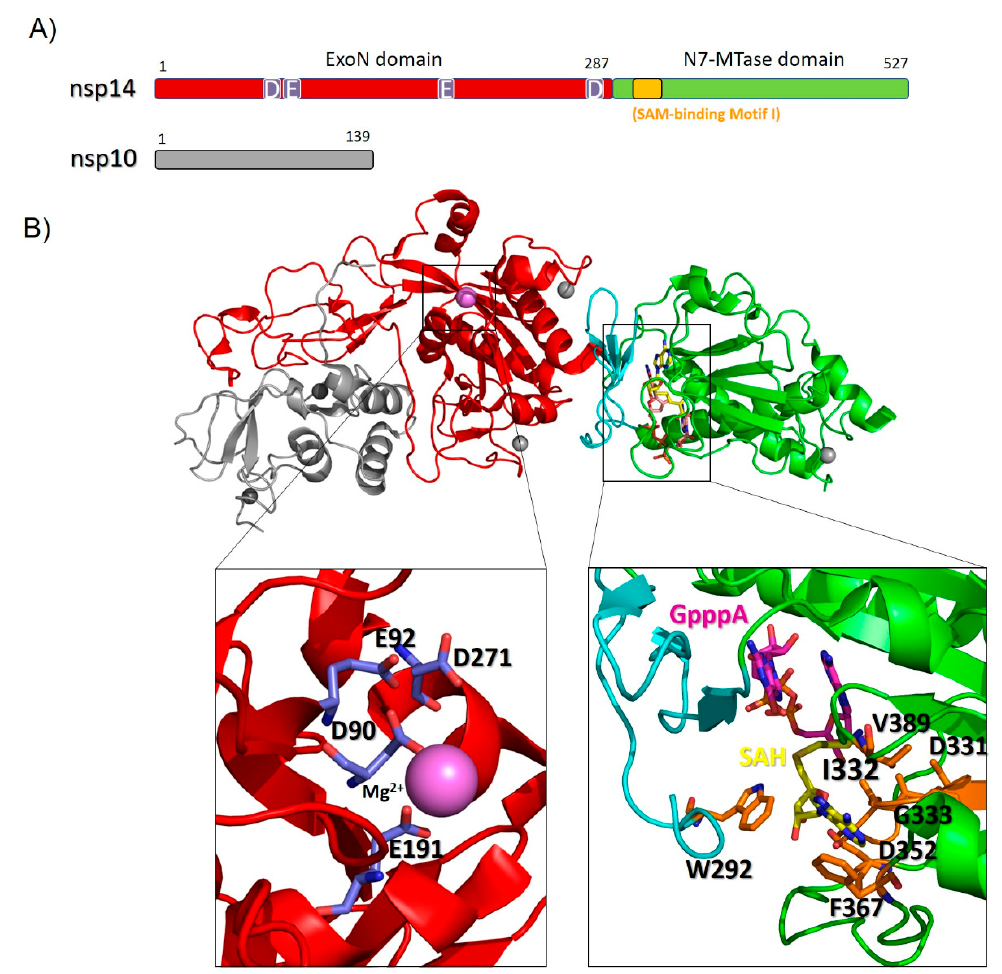
Figure 5. Homology model of SARS-CoV-2 Nsp14-Nsp10 complex. ( A ) Domain organization of Nsp14 and Nsp10; ( B ) Cartoon representation of the homology model of the complex, computed with MODELLER using the structure of its homolog from SARS-CoV as a template (PDB code 5C8S, covered region 1 − 131 in Nsp10 and 1 − 525 in Nsp14). Zinc atoms are shown as grey and a Mg 2+ ion as magenta spheres. Zooms of the catalytic sites are shown in the insets. Catalytic residues of the ExoN domain (left inset) are shown as blue sticks, those of the N7-MTase domain (right inset) are shown as orange sticks; the cap-precursor GpppA (pink), a SAH (demethylated form of SAM) ligand (yellow) and the SAM-binding motif residues (orange) are also represented as sticks.